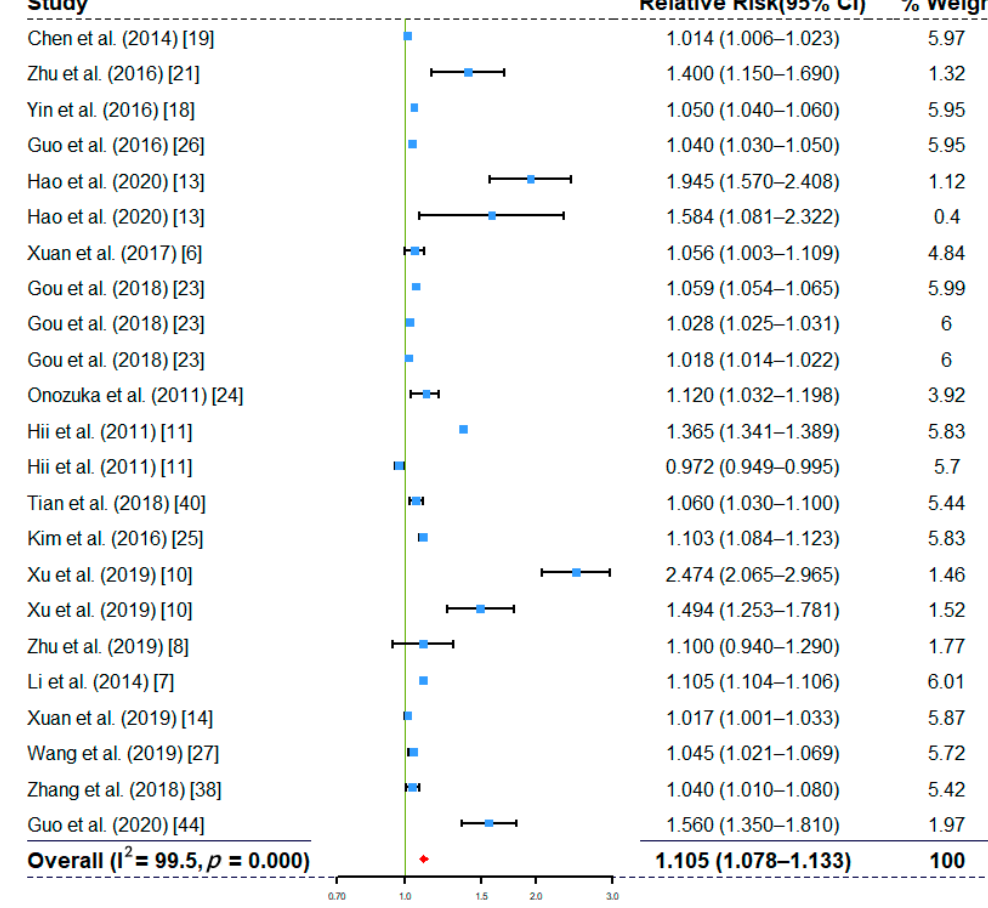
Figure 2. Forest plot showing the effect of ambient temperature on the risk of HFMD based on single-day lag models ( n = 23).